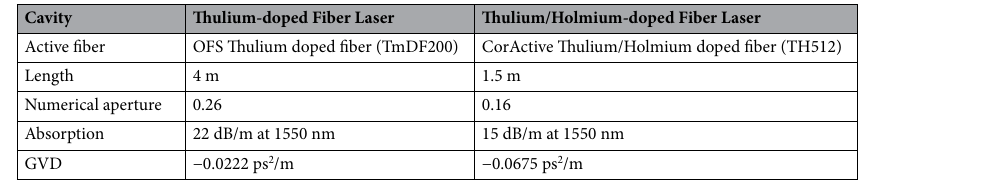
Table 1. Characteristics of the active fibers used in the TDFL and THDFL